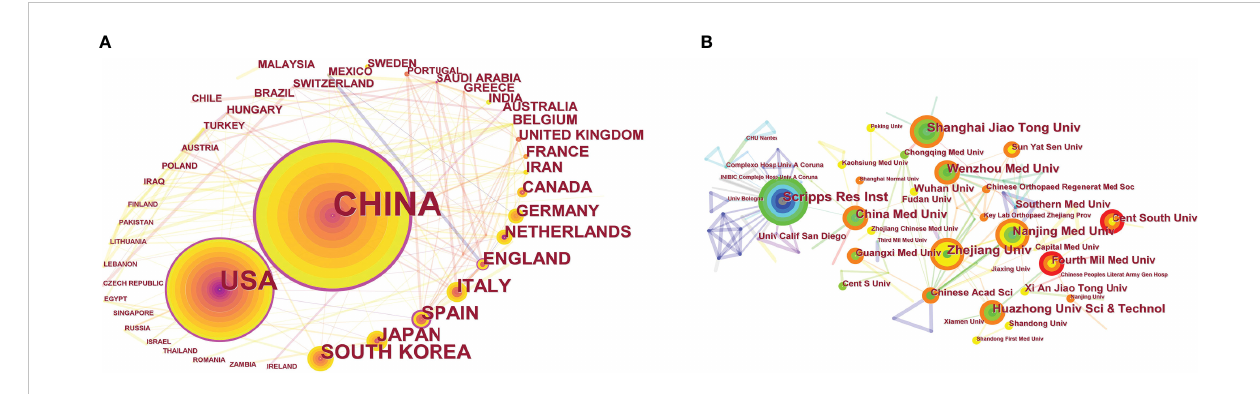
FIGURE 3 CiteSpace visualization map of publications on autophagy in OA from different countries/regions (A) and institutions (B)